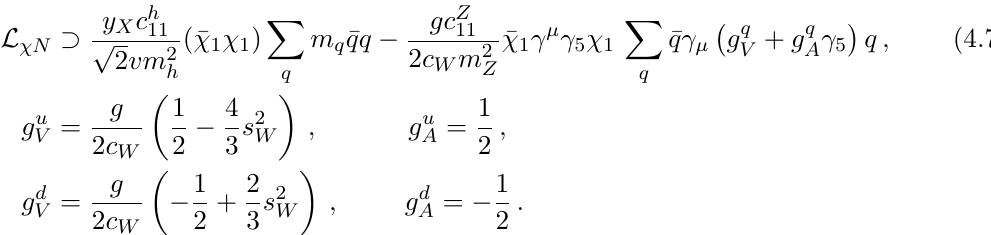
Figure 4 . (cid:31) 1 -DM relic abundance as a function of m (cid:31) and y X = 0 : 8 (dotted), where m N = 400 GeV is (cid:12)xed, and the horizontal lines denote (cid:10) obs 3 (cid:27)